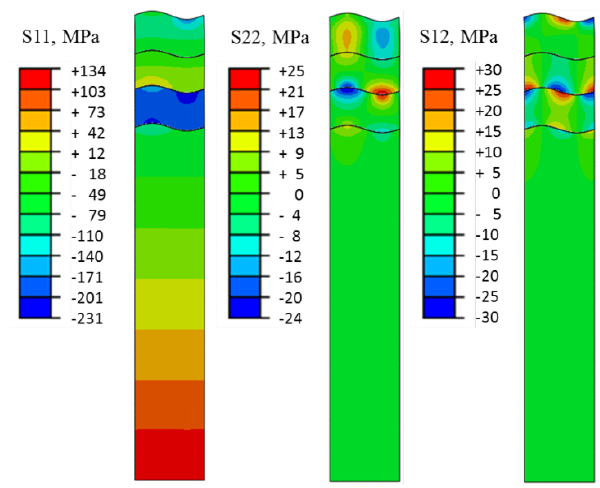
Figure 9. The thermal stress contours of CMCs coating under typical service conditions.